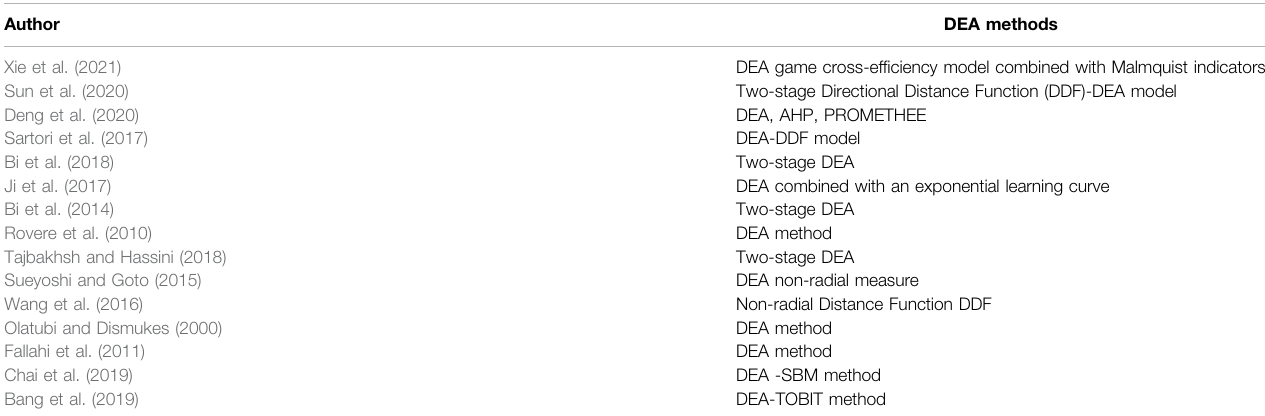
TABLE 12 | Summary of the use of DEA